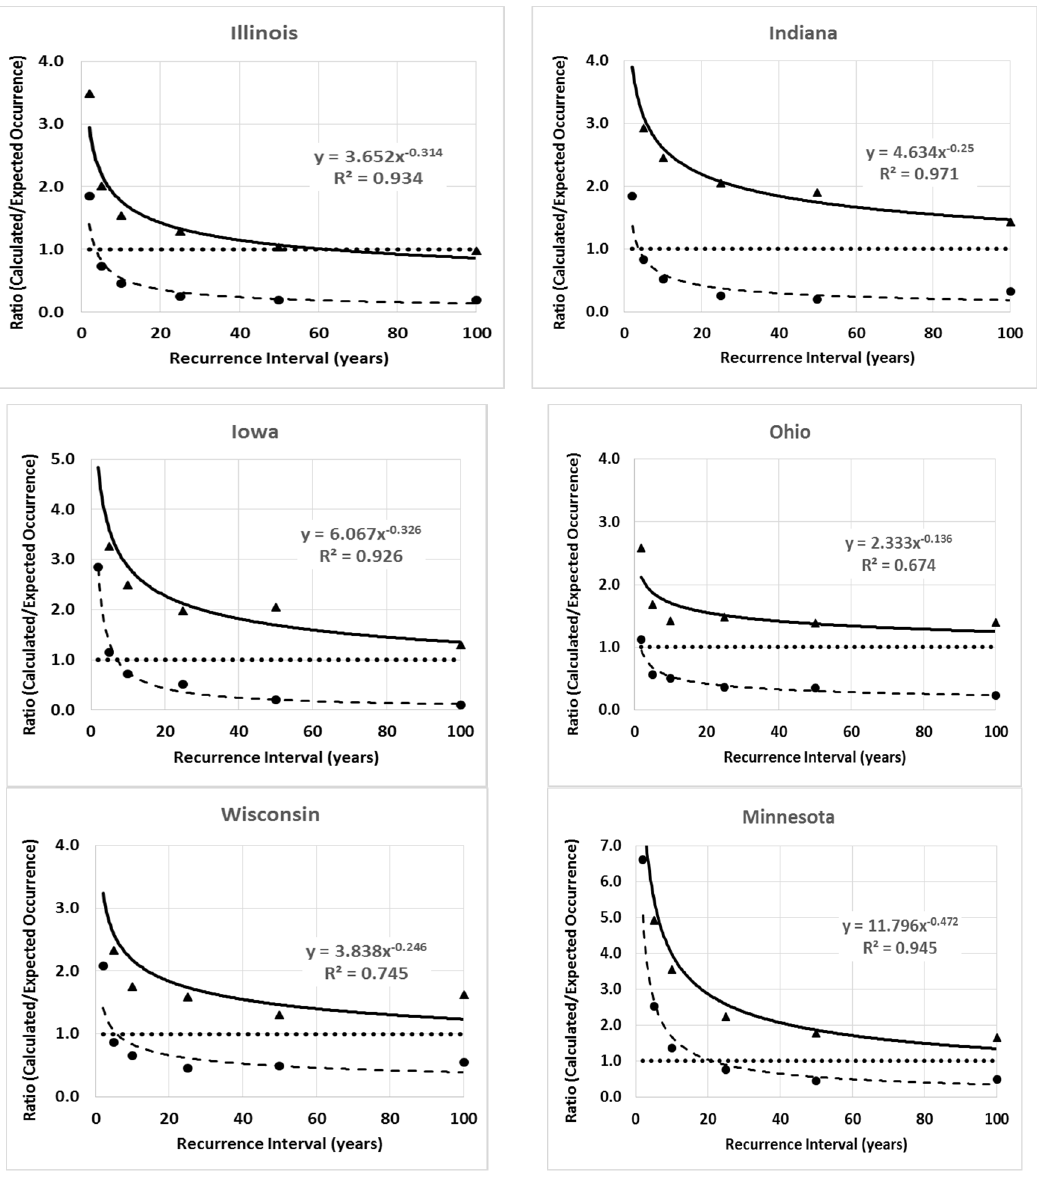
Figure 3. Plots of the ratios of the calculated versus expected occurrences based on the mean discharge of all 25 catchments evaluated for each state (solid triangles). A regression relationship through this data is shown as a solid line together with the relationship and R-squared value. Solid circles and dashed lines are associated with occurrence ratios based on 125% of the discharges calculated with the Log-Pearson Type 3 analysis.